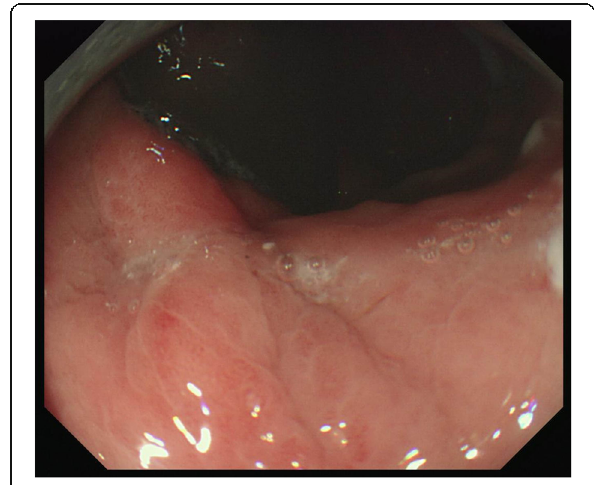
Fig. 3 Esophagogastroduodenoscopy image on postoperative day 23, showing the perforation site completely healed, with